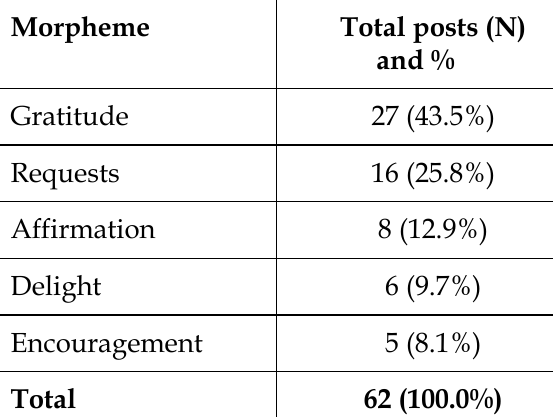
Table 2: Analysis of Posts in Tsukuba Civic Activities